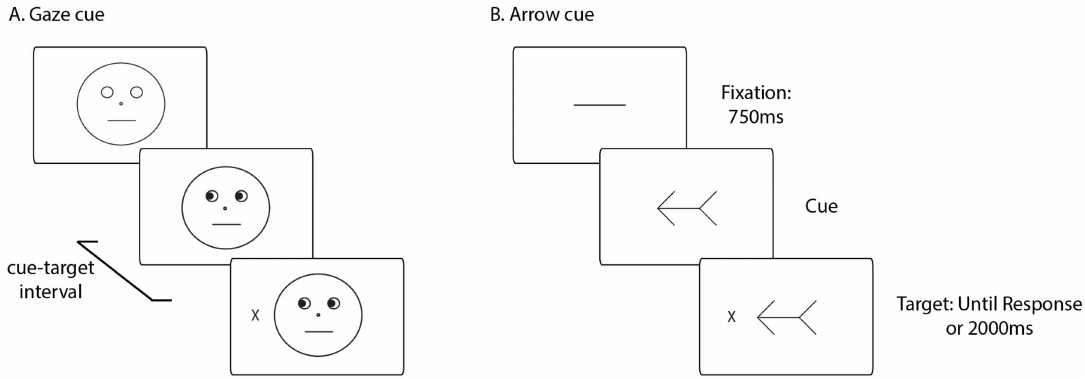
Figure 1. Stimuli and example task sequence for gaze (1A) and arrow (1B) cues. All trials started with a fixation screen, displaying either a blank face or a straight line for 750 ms. Then, the central gaze or arrow cue, indicating either the left or right location was shown. After the variable cue–target time, the response target (a capital letter X) was presented on the left or right of the fixation. The cue and the target remained on the screen until response or until 2000 ms. Cue direction indicated the correct location of the target in 75% of trials. Note: Stimuli are not drawn to